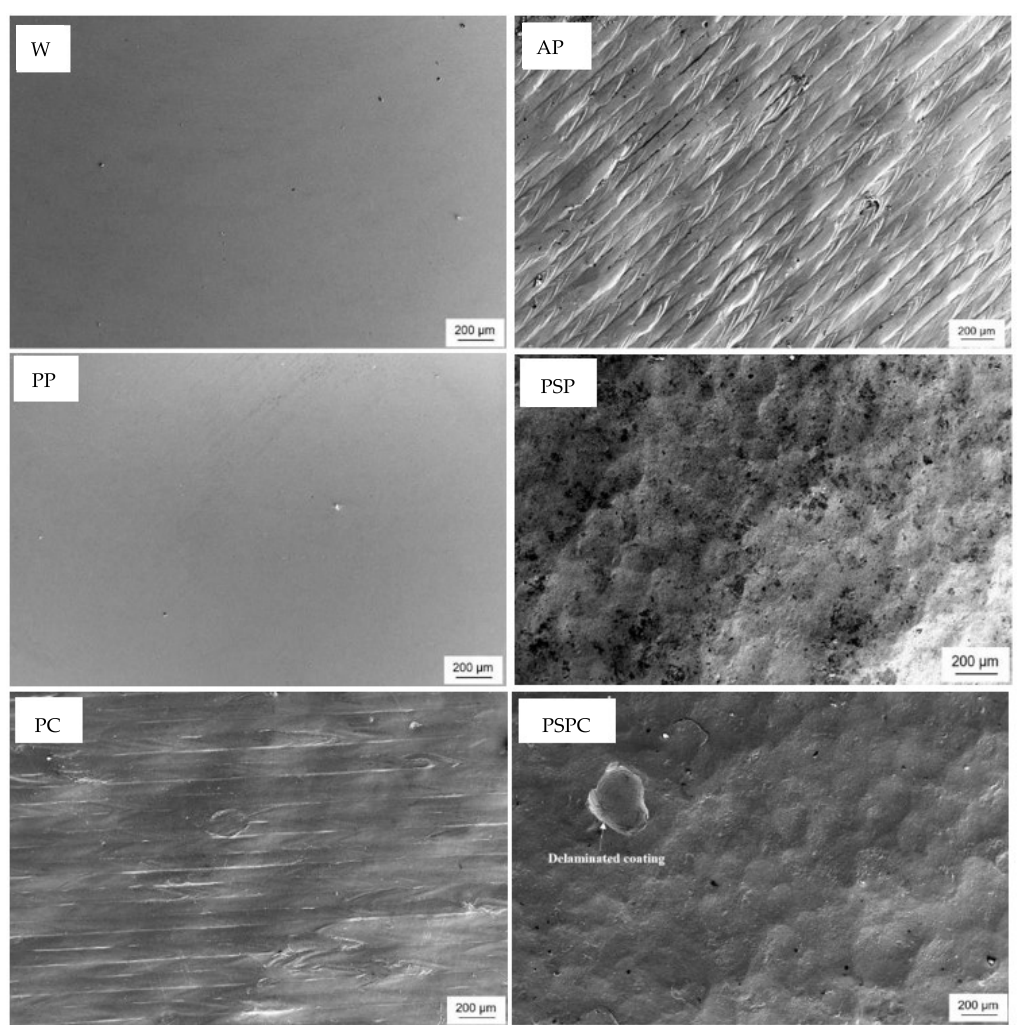
Figure 16. Micrographs of surfaces following corrosion testing.